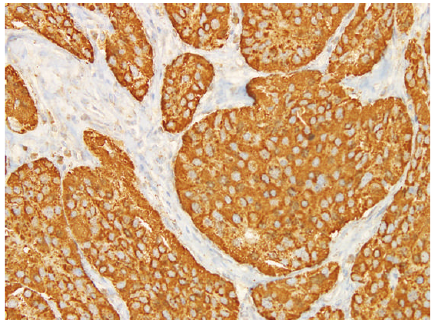
Figure 6: Microscopic view of the goblet cell carcinoid showing strong positive reaction of the tumor for the chromogranin marker (immunohistochemistry